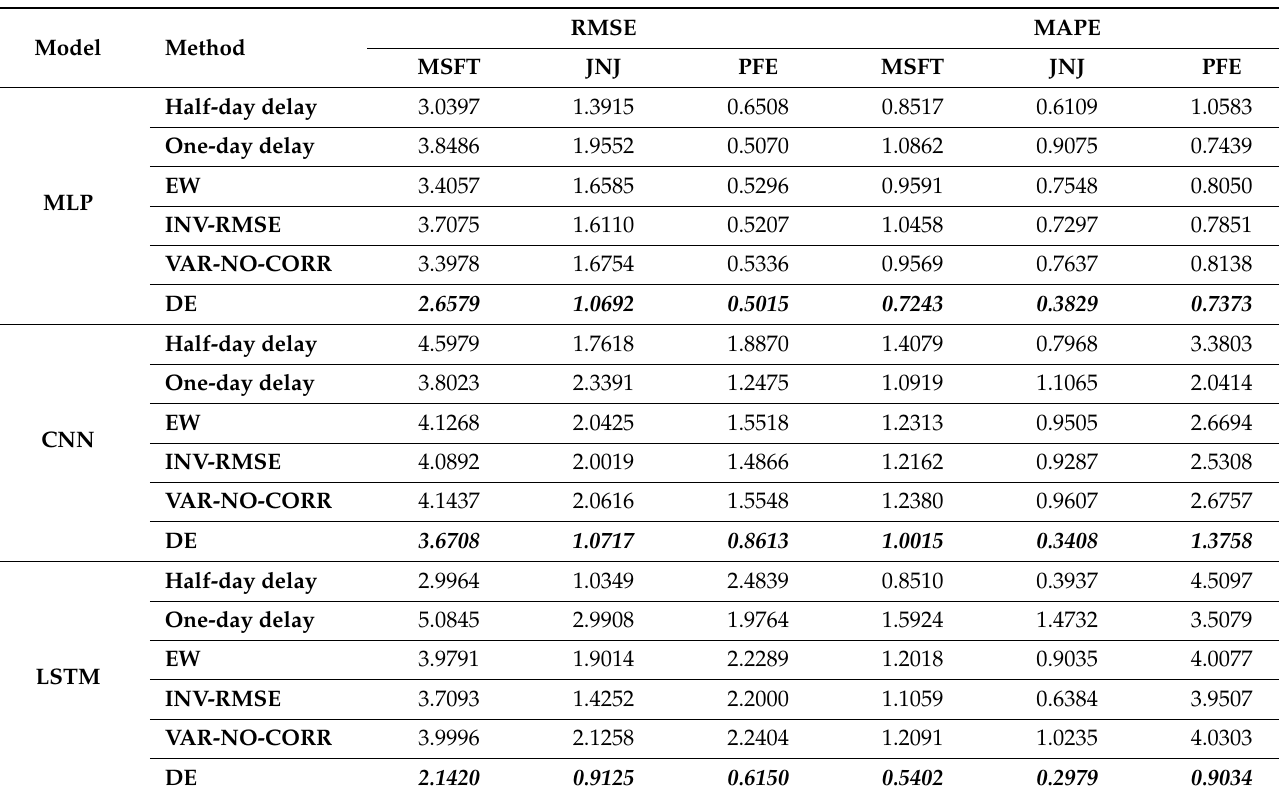
Table 6. Evaluation metrics of the test set on three stocks obtained from the single and the combination forecast methods.